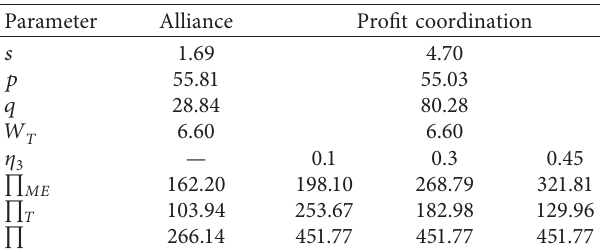
Figure 4: Sensitivity of revenue sharing in semicentralized model 2. Table 9: Coordination results of cost sharing in semicentralized model 2.